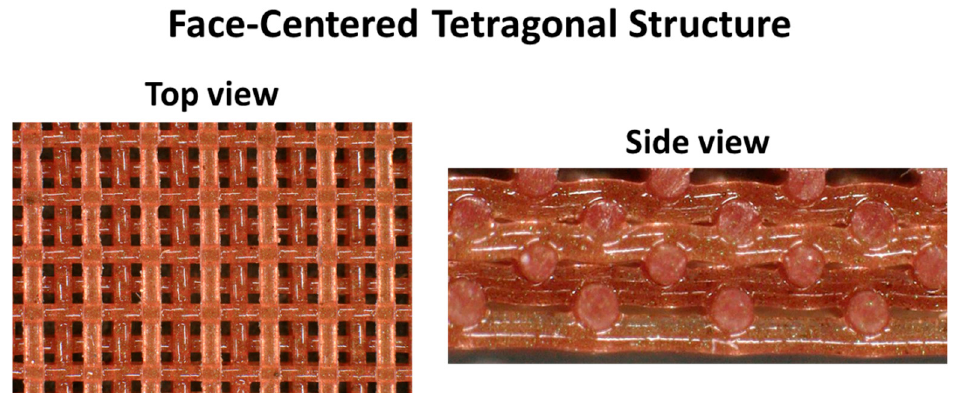
Figure 6. A 3D printed sensor with an FCT structure.